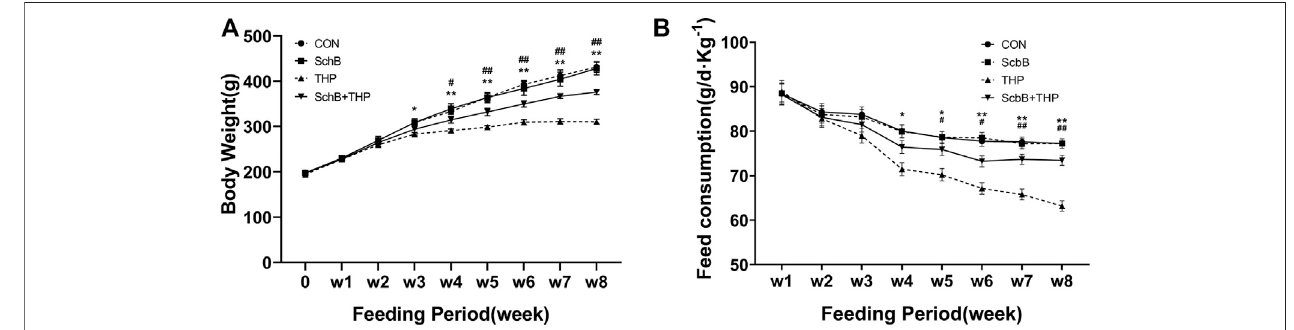
FIGURE 1 | SchB effectively improved the abnormal body weight and food intake of SD rats induced by THP. (A) From the third week, the body weight of rats injectedwithTHPalonewassigni fi cantlylowerthanthatofnormalrats(THPvs.CON ,p < 0.05 ).TheweightlossofTHPratswasfurtherreducedafter4 weeks( p < 0.01, THP vs. CON). In THP rats treated with SchB (50 mg*kg − 1 ), weight loss was signi fi cantly improved ( p < 0.05 , SchB + THP vs. THP). The improvement was more signi fi cantafter the fi fthweek( p < 0.01, SchB+THP vs. THP). (B) Fromthefourth week, thefood intakeofratsinjected withTHP alone wassigni fi cantlylowerthan thatofnormal rats(THPgroup vs.CON group, p < 0.05).ThefoodintakeofTHP ratsdecreasedfurther after6 weeks( p < 0.01, THP and CON).InTHPratstreatedwith SchB (50 mg*kg − 1 ), the food intake increased signi fi cantly ( p < 0.05 , SchB + THP vs. THP). The improvement was more signi fi cant after the seventh week ( p < 0.01, SchB + THP vs. THP). All values are mean ± SD. *p < 0.05 vs. CON , ** p < 0.01 vs. CON; # p < 0.05 vs. THP, and ## p < 0.01 vs. THP